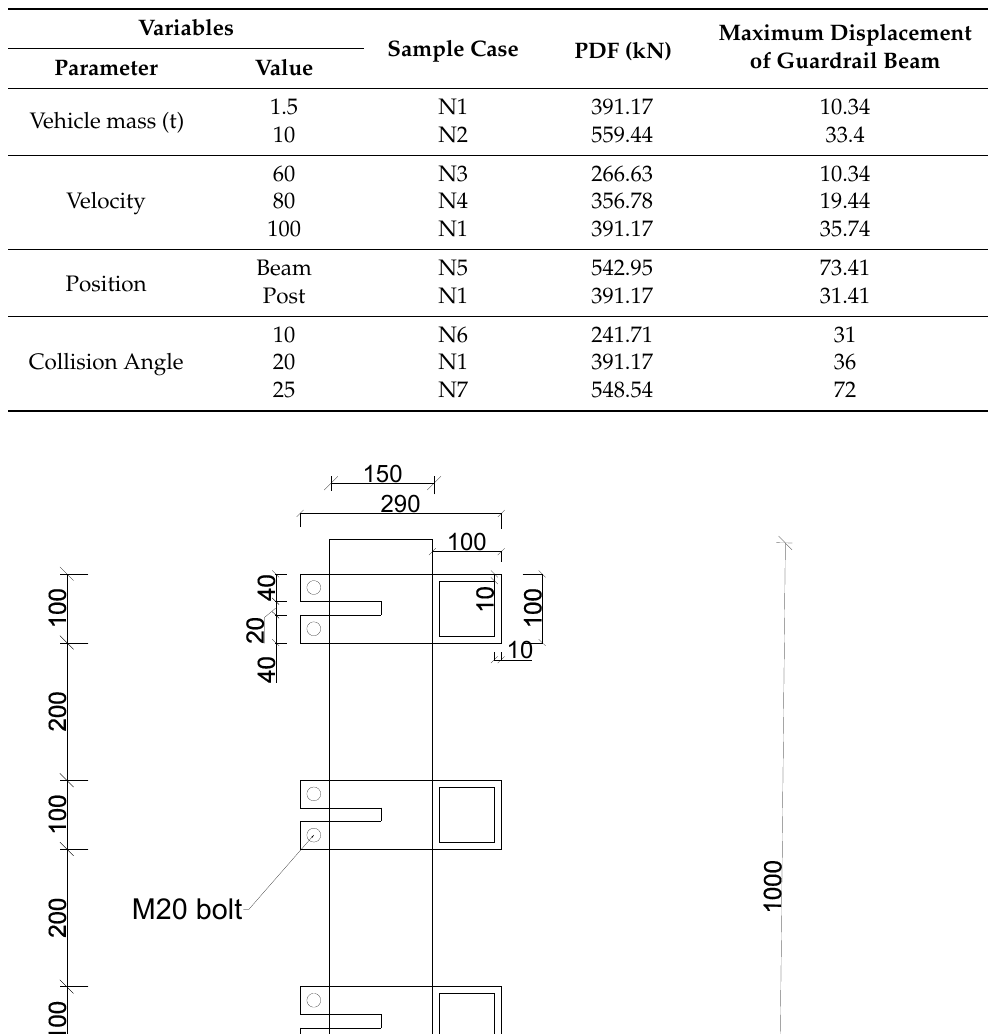
Table A8. Summary of the FE results.